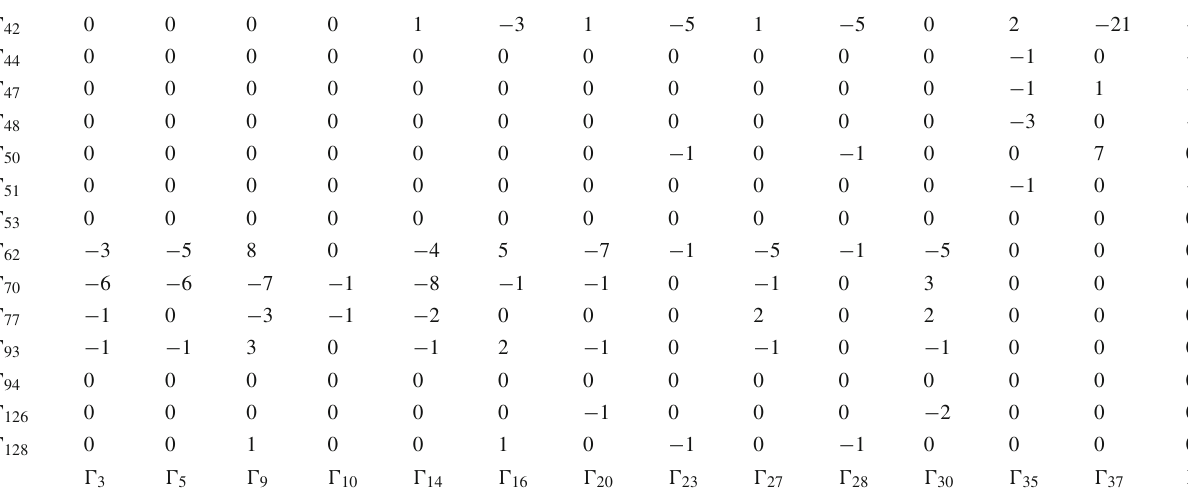
Table 306 Basis quantities correlation coefficients in percent, subtable 2